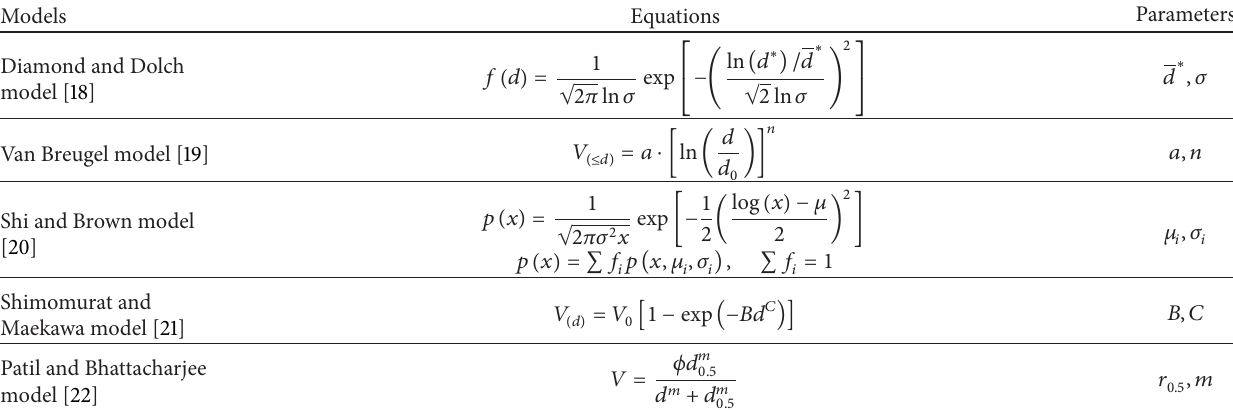
Table 4: Pore size distribution models of cement-based